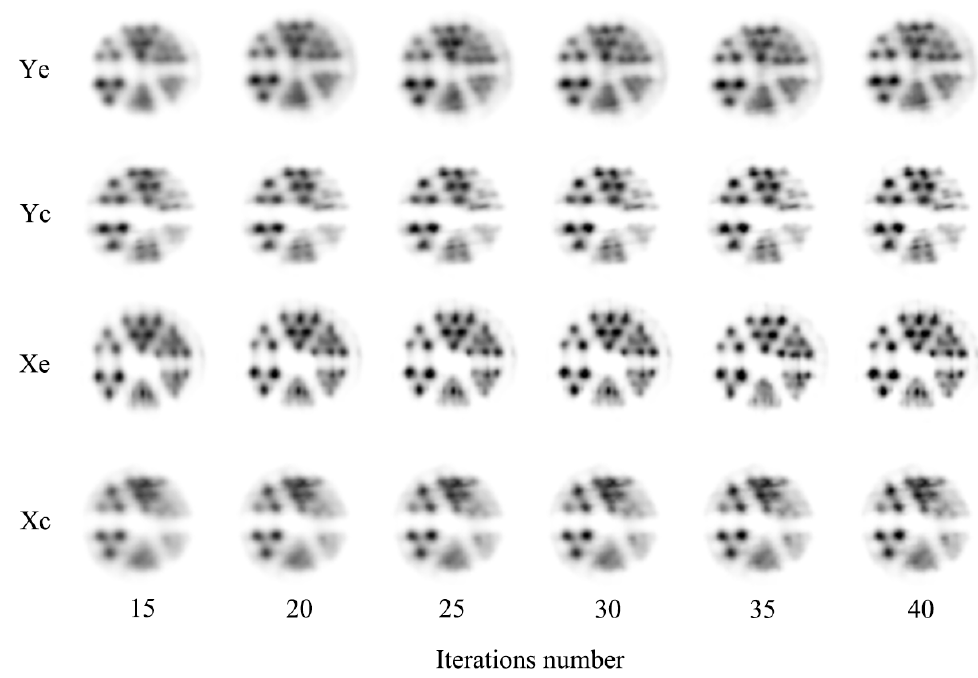
Figure 4. The PET images of the Derenzo phantom reconstructed by the 3D-MLEM (iteration 40) algorithm in different orientations and positions, and at different iteration numbers.